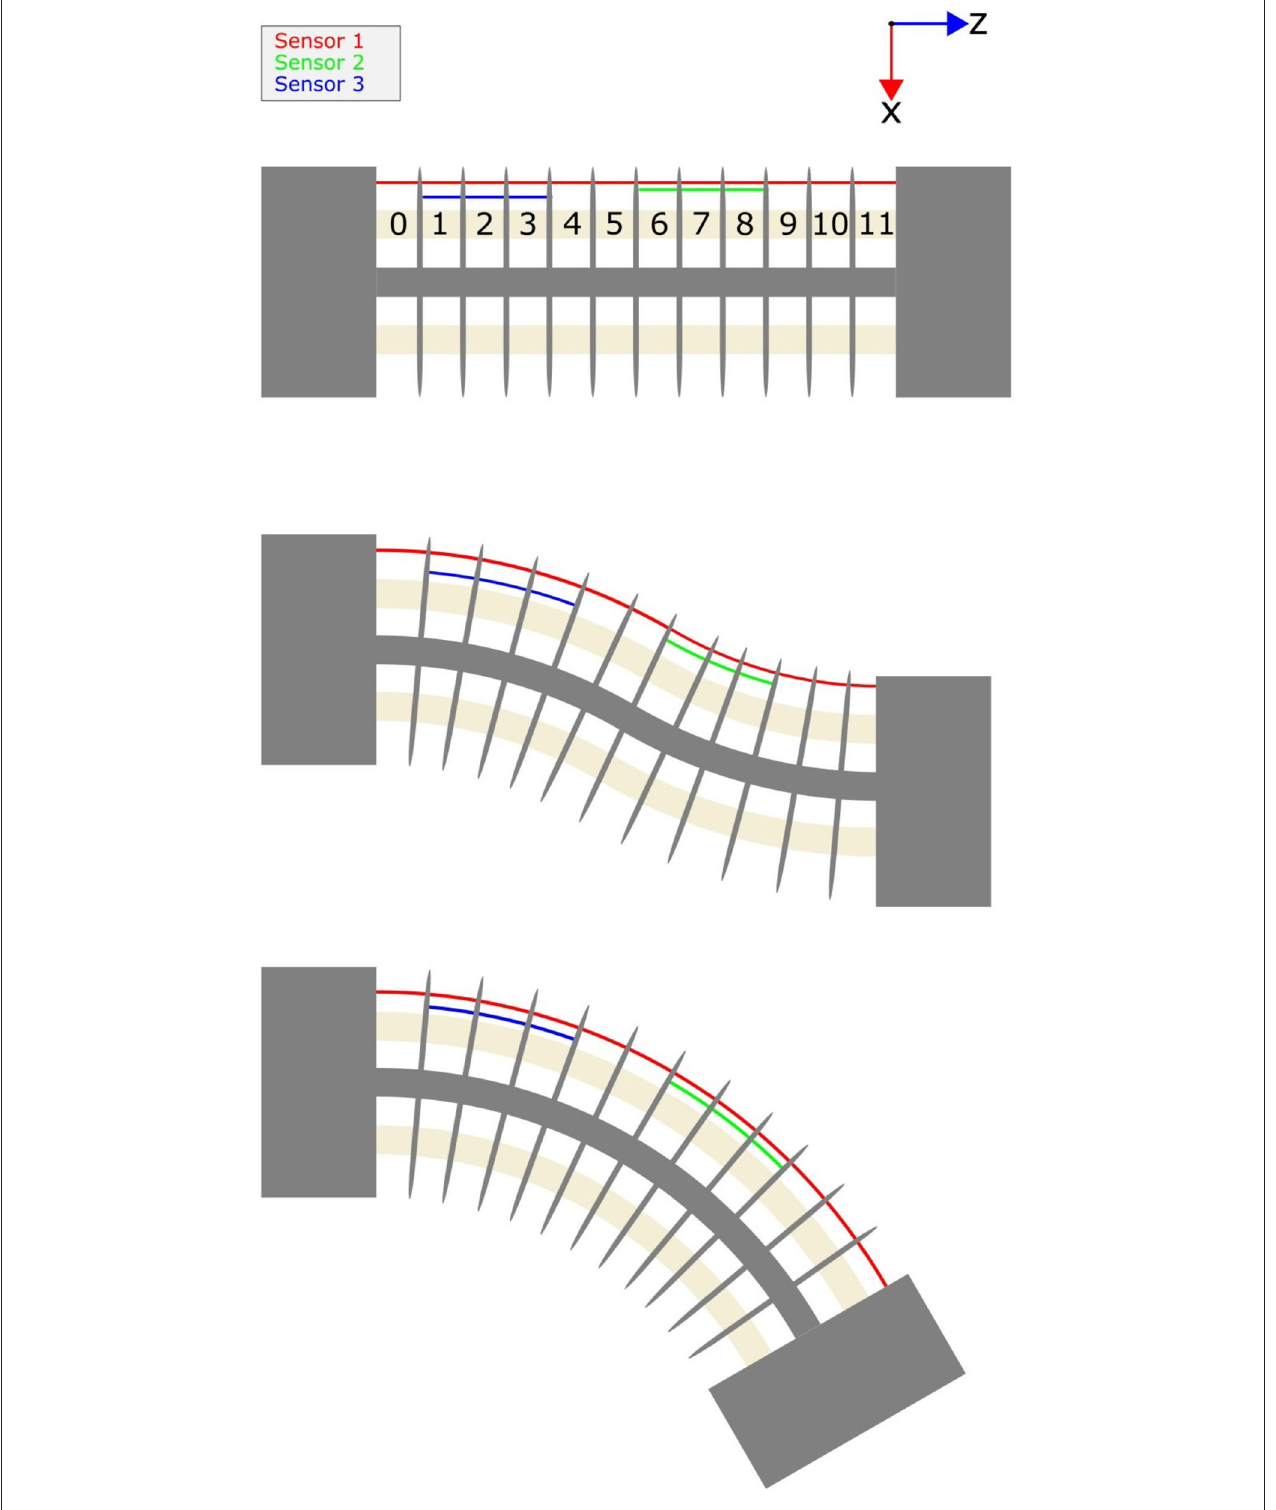
FIGURE 4 | An illustration of showing three possible bending states of a continuum joint, the segment indexing used in this paper, and a possible sensor configuration.